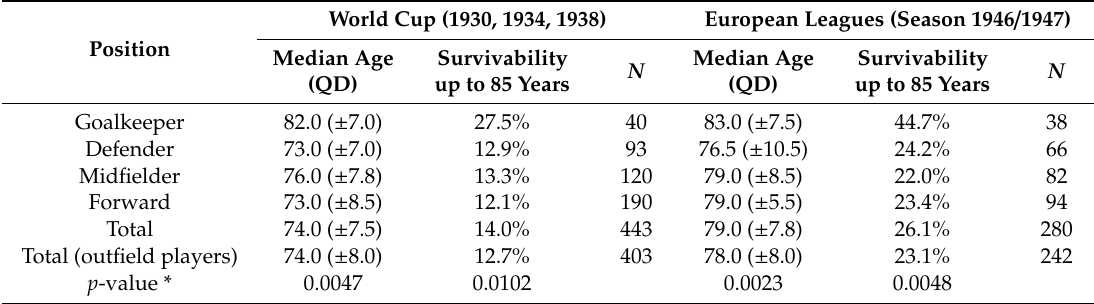
Table 1. The lifespan of elite football players born before 1922 with regard to the position occupied on the